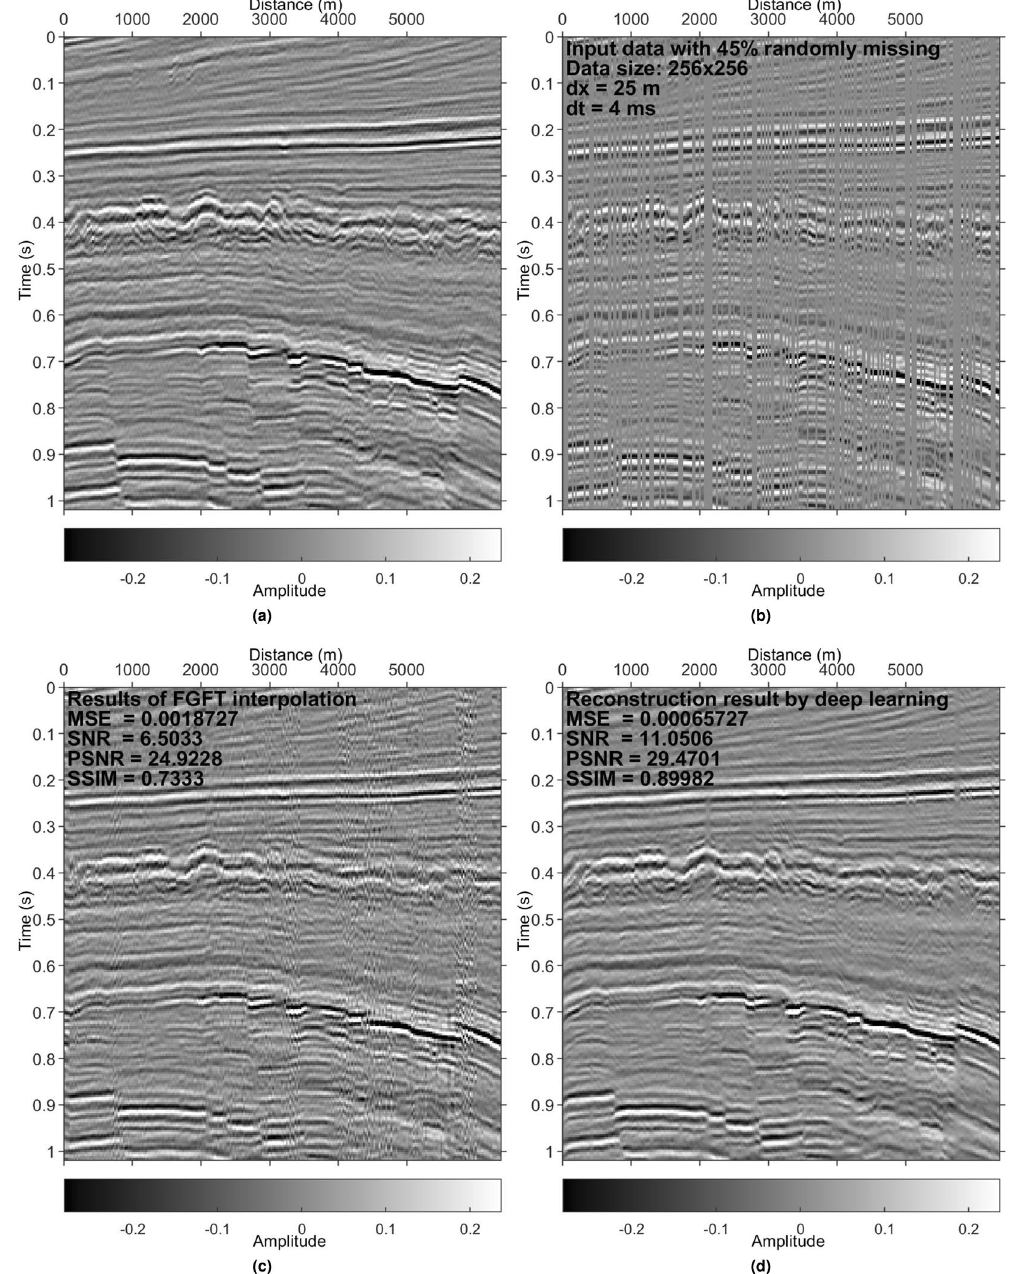
Figure 11. Results on the F3 data set. ( a ) Reference data. ( b ) Irregularly sampled data with 45% missing. ( c ) Interpolated data using the FGFT interpolation method 23 . ( d ) DL reconstruction